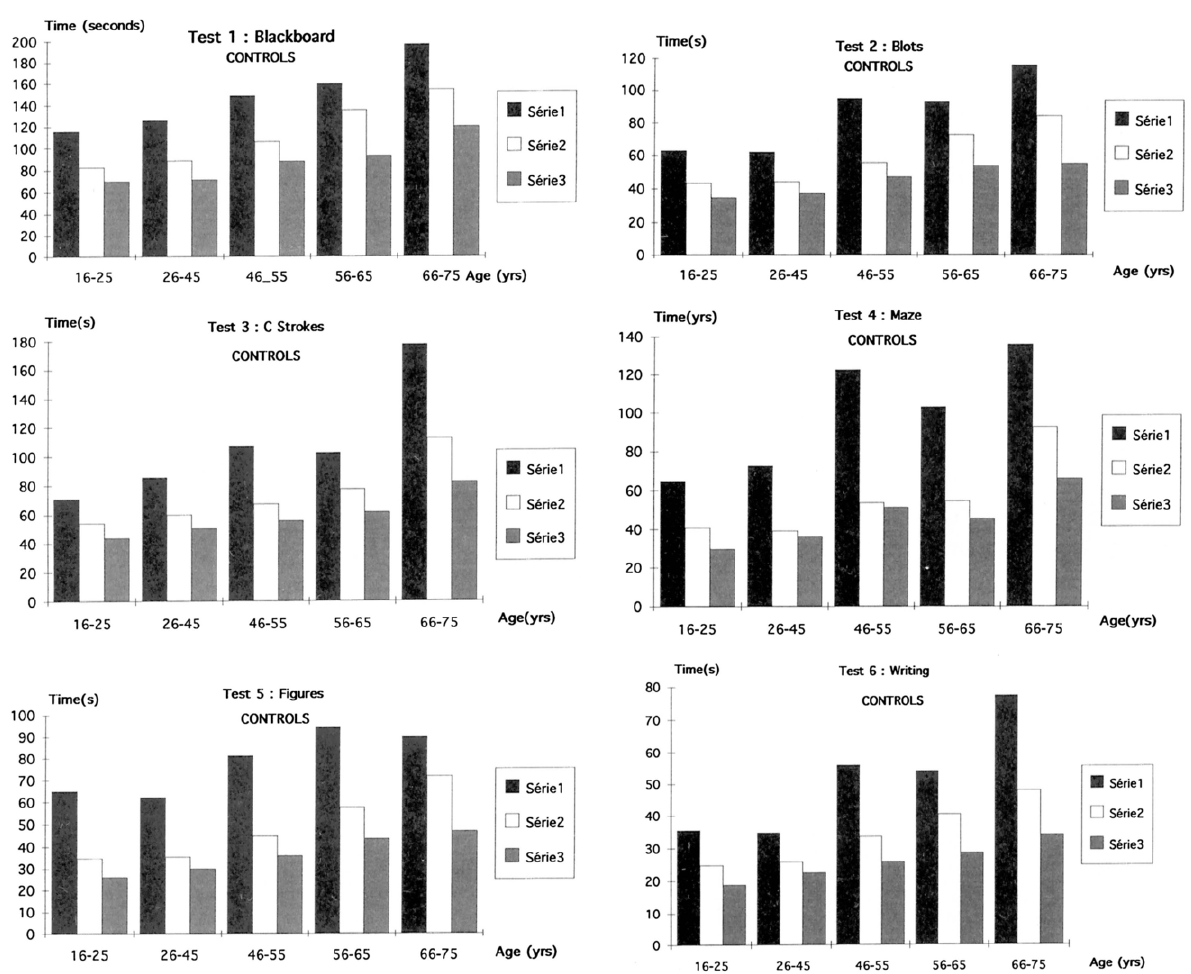
FIG. 1. Performance of control group in five age groups. Mean response times in six tests for three sessions.